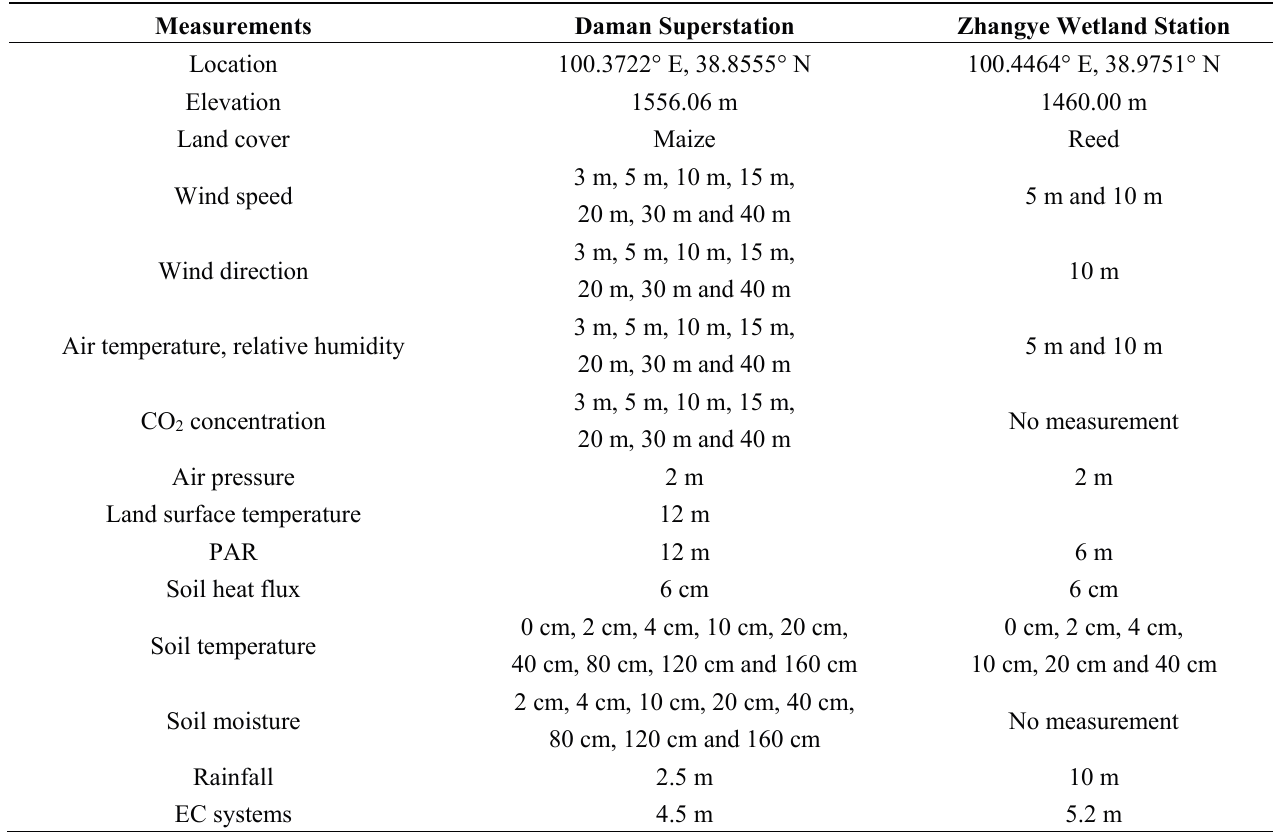
Table 1. Observing items at the Daman superstation and Zhangye wetland